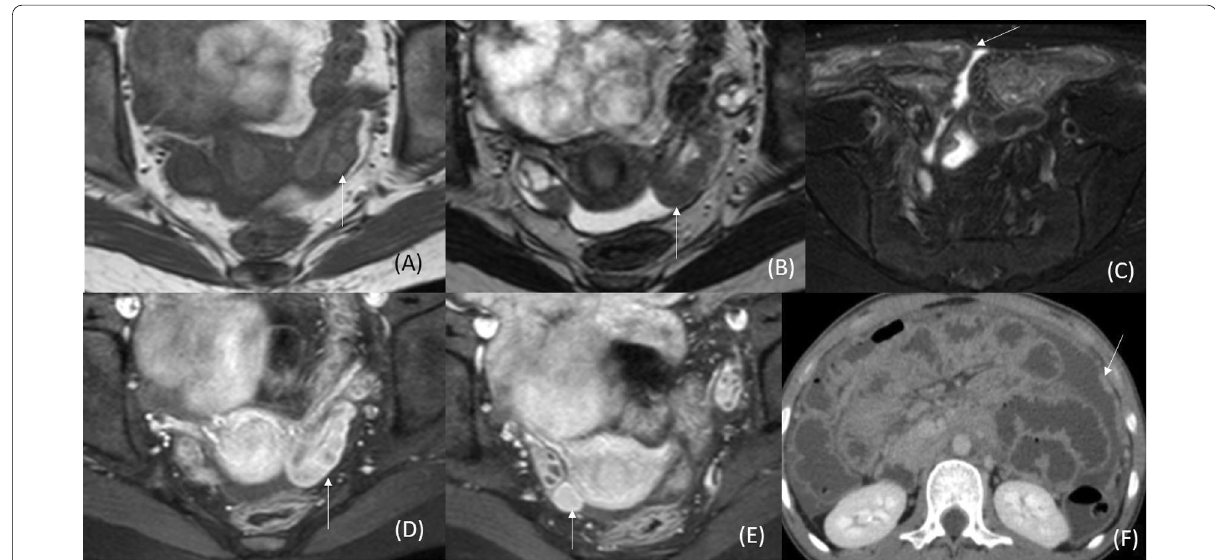
Fig. 13 Female genital tuberculosis—bilateral fallopian tube involvement, ascites and peritoneal thickening. MRI pelvis of a 25-year-old-female shows dilatation of bilateral fallopian tubes with hyperintense wall on T1W image ( A ), wall is hypointense on T2W ( B ), free fluid in pouch of Douglas and endometrial cavity ( B ). T2 fat-supressed image shows ascites ( C ), T1 contrast-enhanced images show peripheral enhancement of bilateral fallopian tubes ( D , E ), CT shows irregular peritoneal thickening ( F )